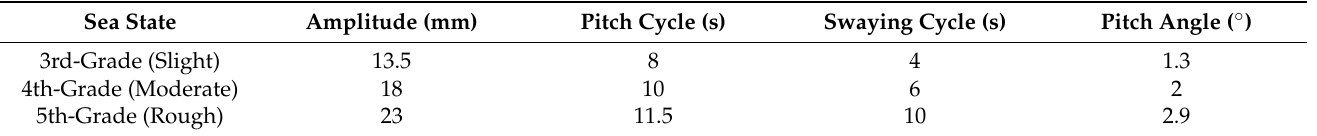
Table 7. Parameters When Simulating the Motion of the Deck under Each Sea